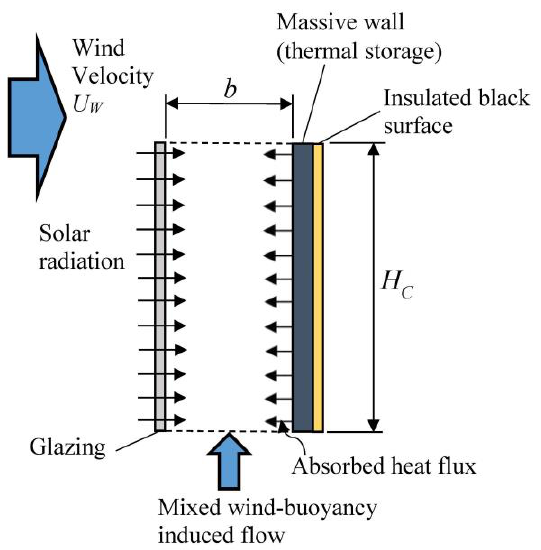
Figure 4. General arrangement of the thermally active walls forming main channels in a solar chimney system.